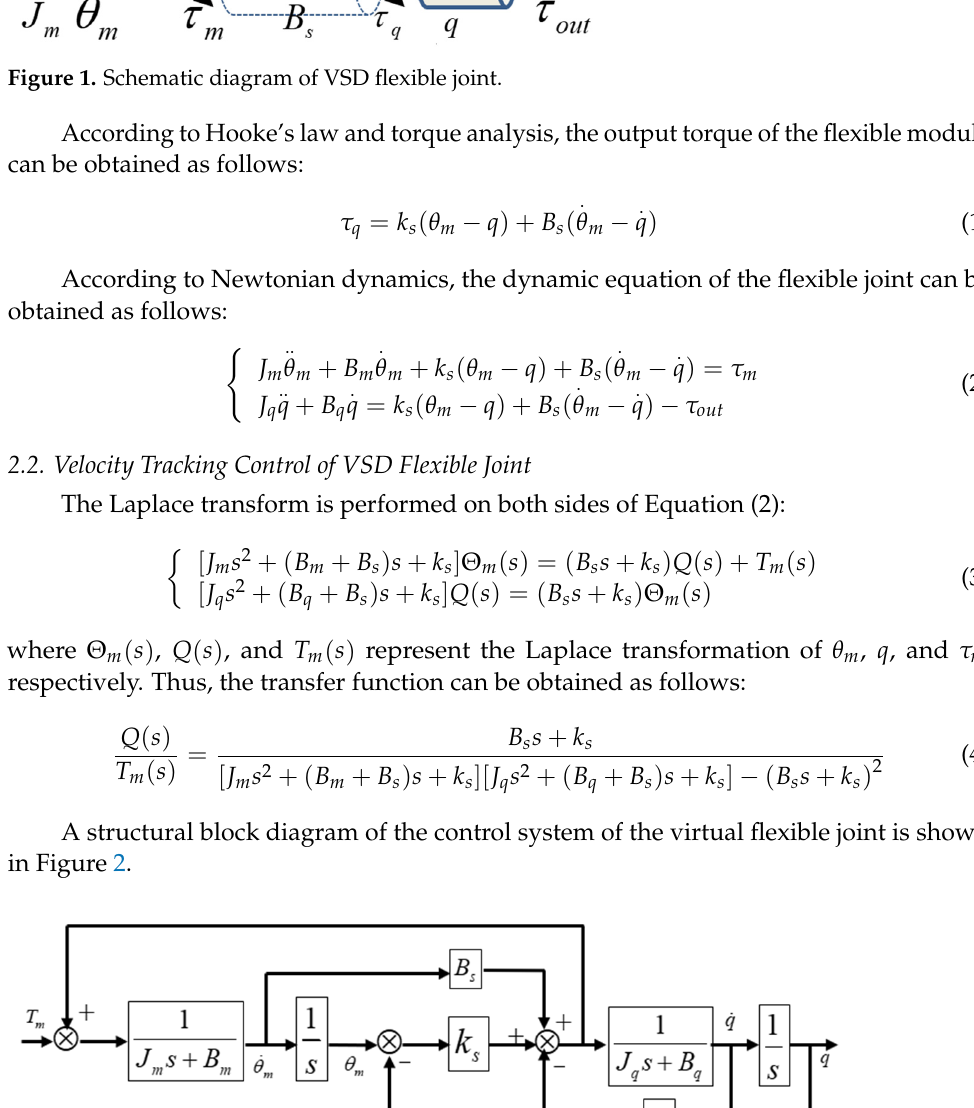
where u ( t ) is the control voltage; i ( t ) is the actual current of motor armature coil; L is the inductance of the armature coil; R is the armature coil resistance; k b is the electromagnetic . θ m is the angular velocity of the motor shaft; and k m is the motor torque torque coefficient;